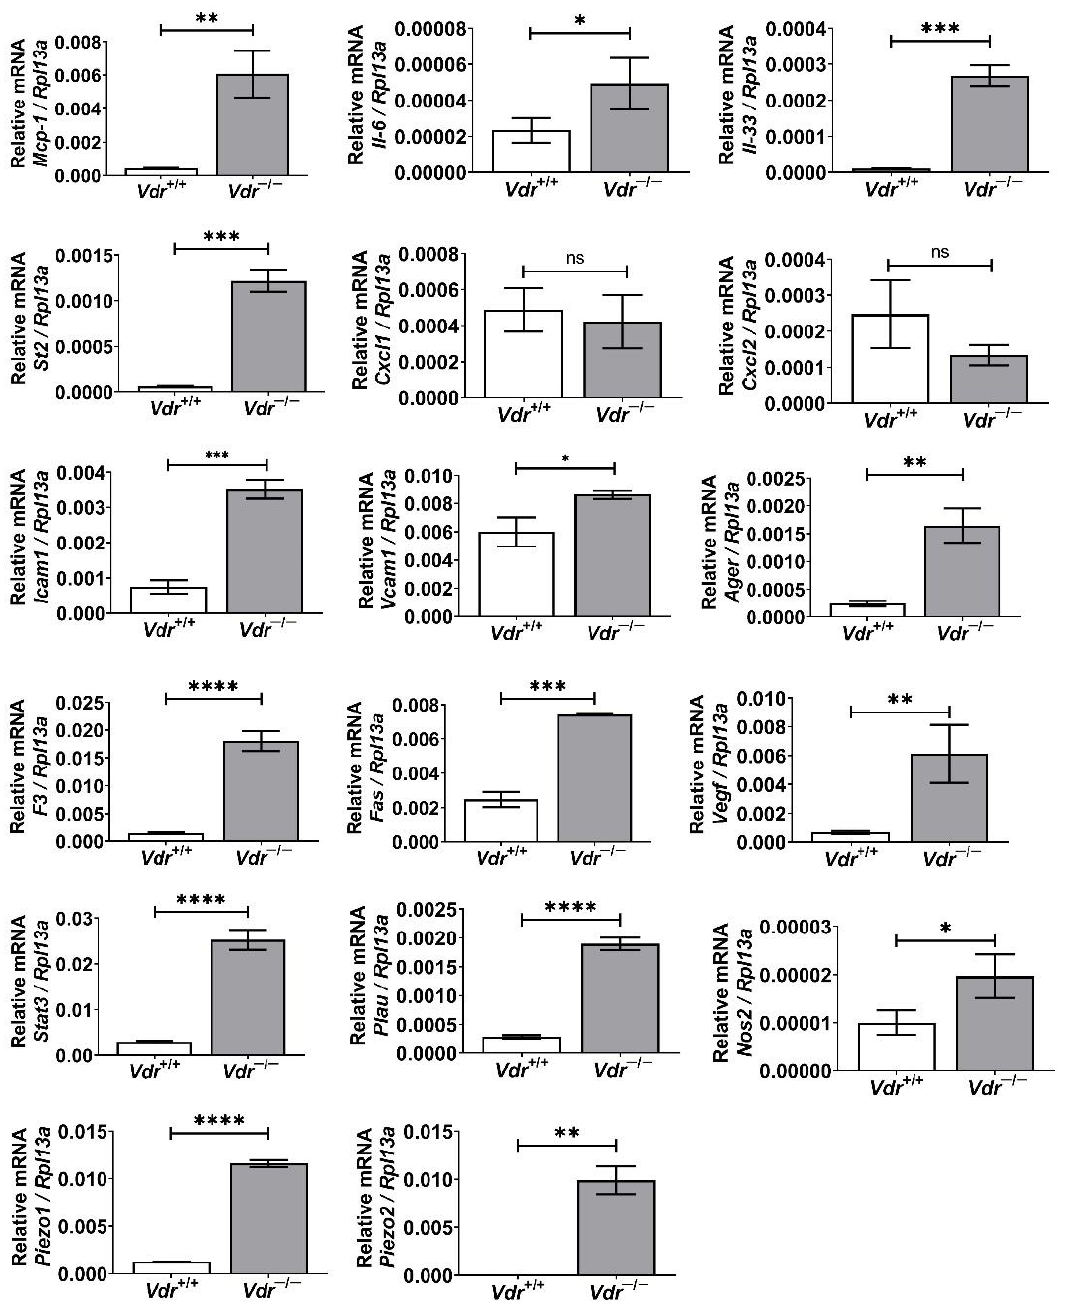
Figure 6. Increased expression of pro-inflammatory mediators in Vdr −/− retinal EC. Expression levels of Mcp-1, Il-6, Il-33, St2, Cxcl1, Cxcl2, Icam-1, Vcam-1, Ager, F3, Fas, Vegf, Stat3, Plau, Nos2, Piezo1, and Piezo2 were determined by qPCR analysis. Expression levels of target genes were normalized by Rpl13a (60 S ribosomal protein L13a) expression. (n = 3, * p < 0.05, ** p < 0.01, *** p < 0.001, **** p < 0.0001; ns: not significant).